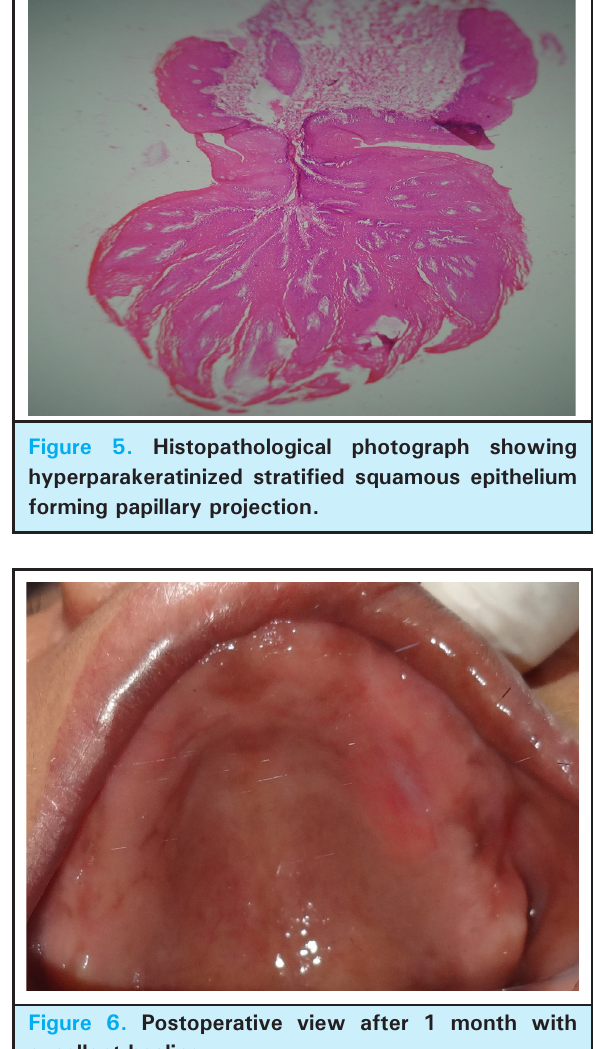
only on clinical and histopathologic characteristics